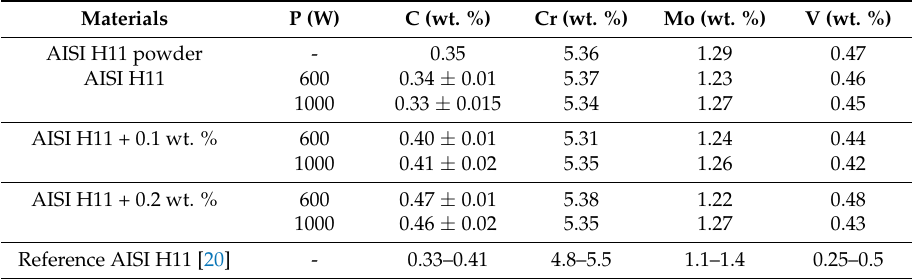
Table 3. Chemical composition of selected ten-layered samples with respect to the laser power and the added nanoparticle content ( (cid:1865)(cid:4662) = const. = 3.7 ± 0.1 g/min, f rate = 400 mm/min)